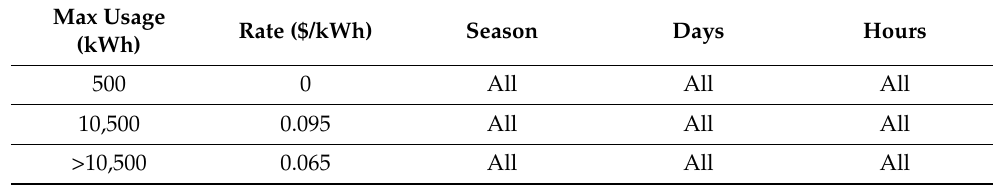
Table A2. USBIA—San Carlos